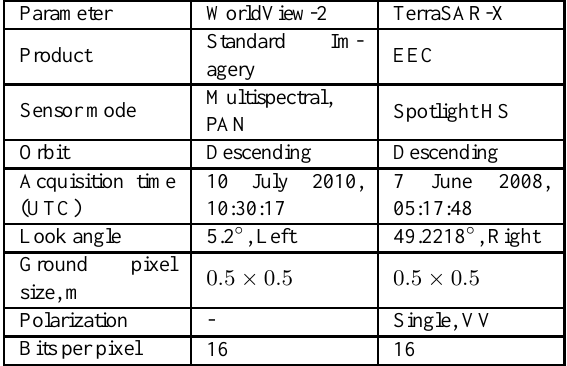
Table 1: Parameters of the WorldView-2 and TerraSAR-X data for the test scene